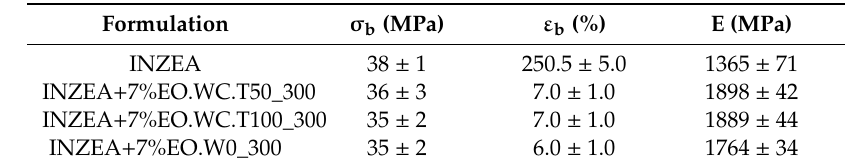
Table 9. Mechanical parameters for INZEA bio-nanocomposites with MMT samples functionalized with 300 wt% LEO (m ± SD; n = 5).